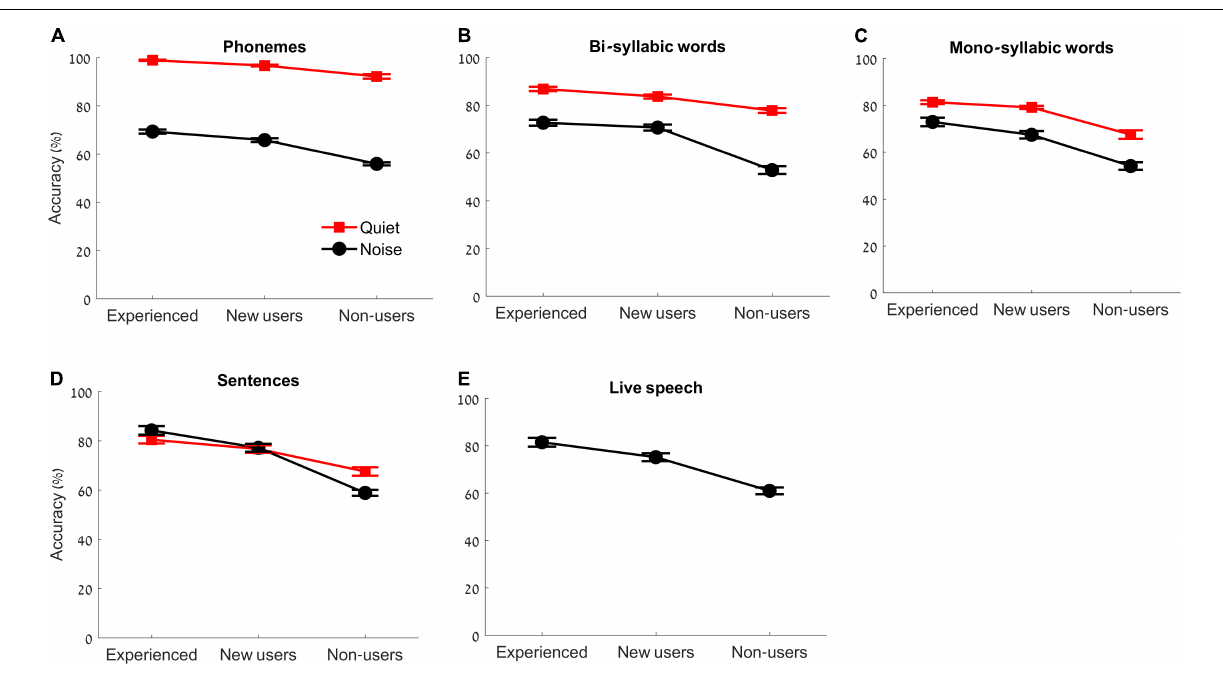
FIGURE 6 | Task accuracy (%) for the experienced users, new users, and non-users, across the following tasks: (A) Phonemes, (B) Bi-syllabic words, (C) Mono-syllabic words, (D) Sentences in both quiet (red) and in noise (black) and for (E) Live speech. Error bars represent standard errors of the